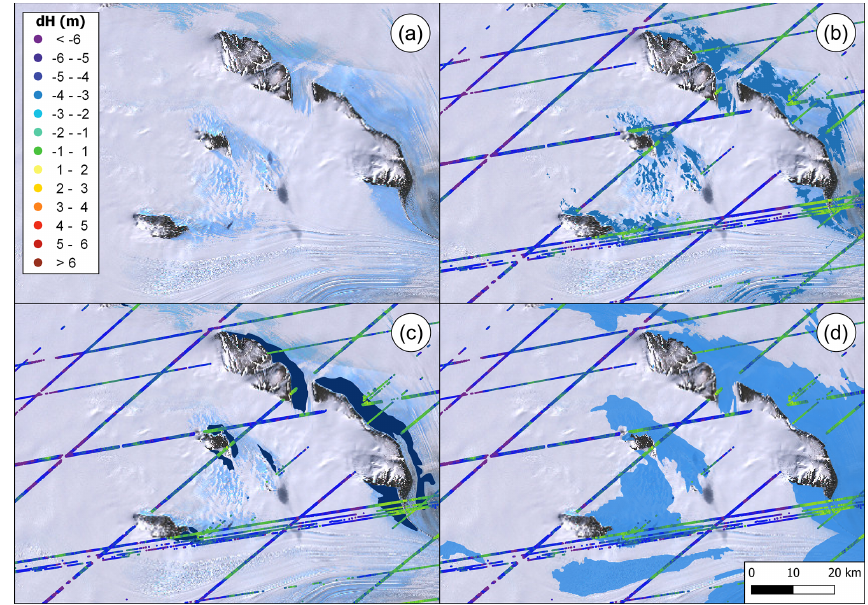
Figure 14. (a) Subset of Landsat image used for classification, (b) proposed BIA classification, (c) AADC BIAs, and (d) AntarcticaLC2000 BIAs. Panels (b–d) are overlaid with the height differences of TanDEM-X minus ICESat.